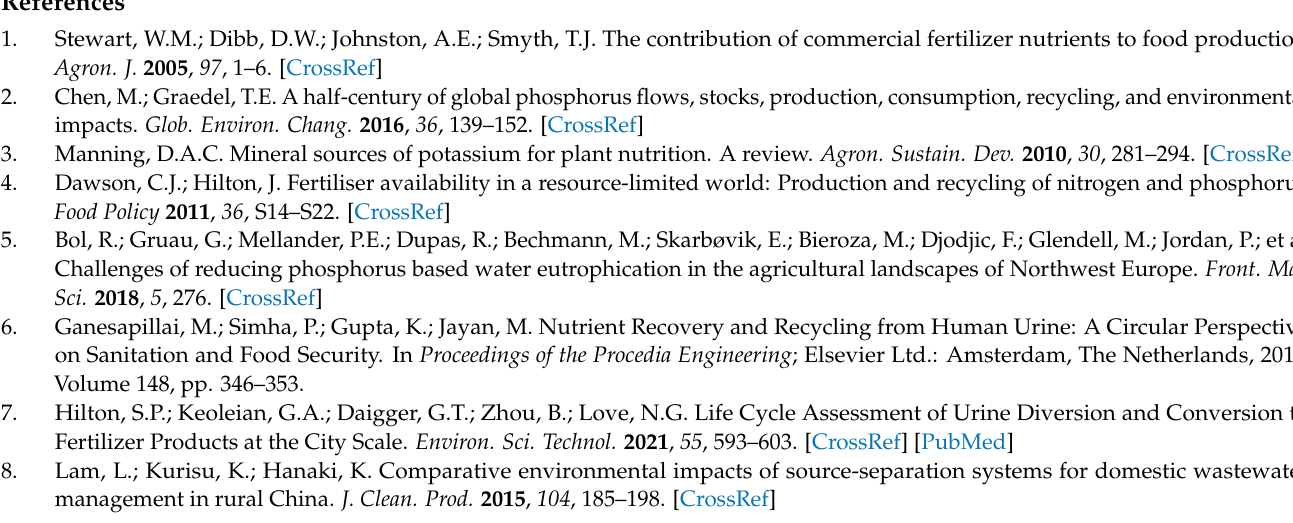
community K-Struvite samples ordered by the indicator value, Table S11: The top 10 genera ordered by node degree in the lettuce root-associated bacterial community networks grouped per urine- derived fertilizer treatment, Table S12: The top 10 hubs ordered by Kleinberg’s hub centrality score in the lettuce root-associated bacterial community networks grouped per urine-derived fertilizer treatment, Table S13: The top 10 genera ordered by node degree in the lettuce root-associated bacterial community networks grouped per root zone, Table S14: The top 10 hubs ordered by Kleinberg’s hub centrality score in the lettuce root-associated bacterial community networks grouped per root zone, Table S15: Differentially abundant OTUs linked to the lettuce performance and nutritional composi- tion metrics grouped per fertilizer treatment, Table S16: Overview of the habitats and characteristics of the key genera and families in the lettuce root-associated bacterial communities fertilized with urine-derived fertilizer. References [116–170] are cited in the Supplementary